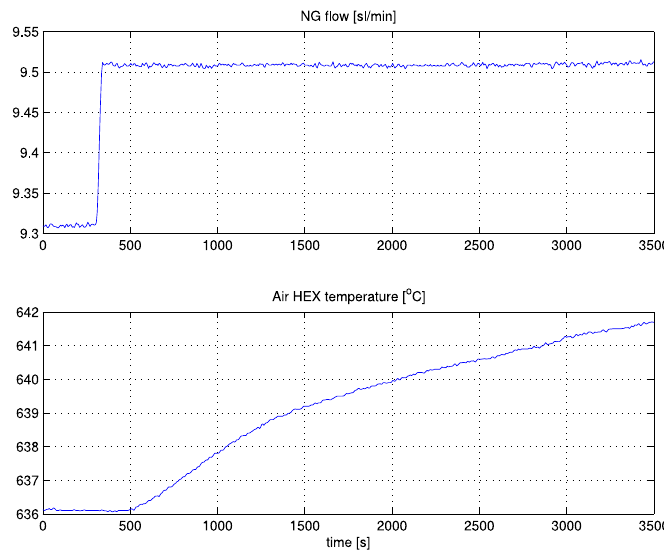
Figure 26. Open-loop response of Air HEX control loop.